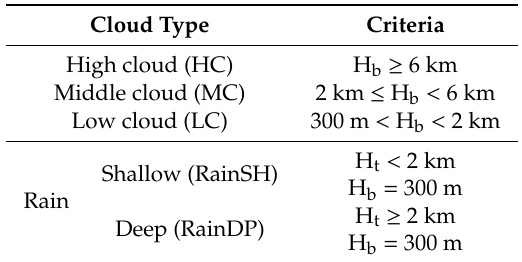
Table 4. Classification criteria of cloud types. The H b and H t indicate the height of the cloud base and the